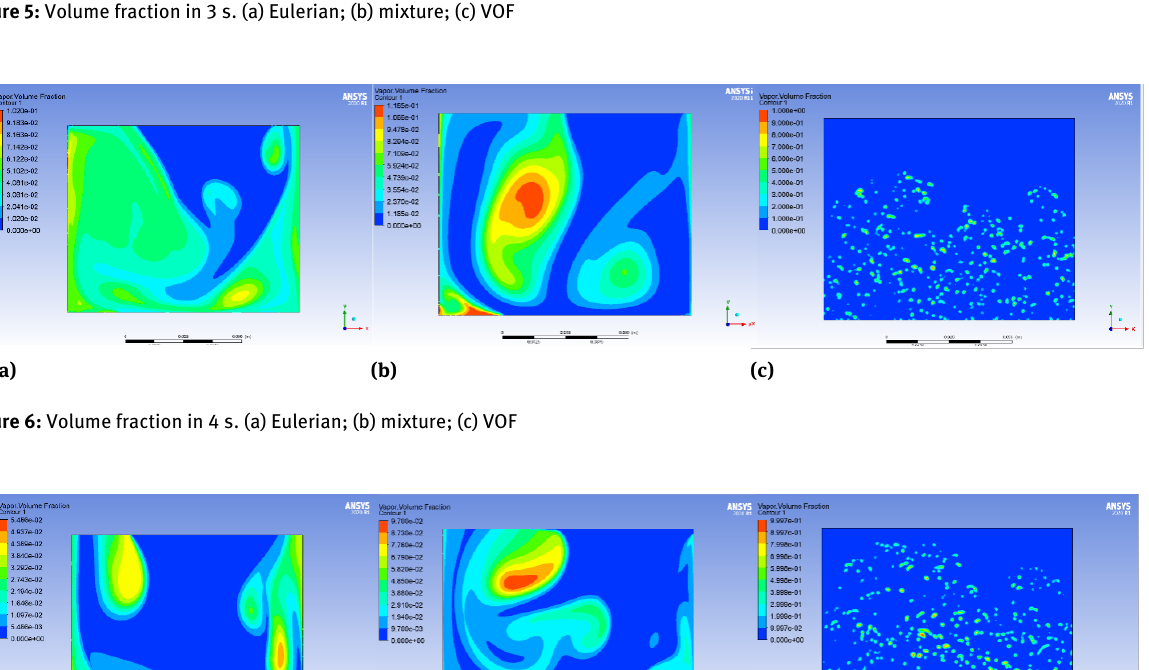
Figure 5: Volume fraction in 3 s. (a) Eulerian; (b) mixture; (c) VOF